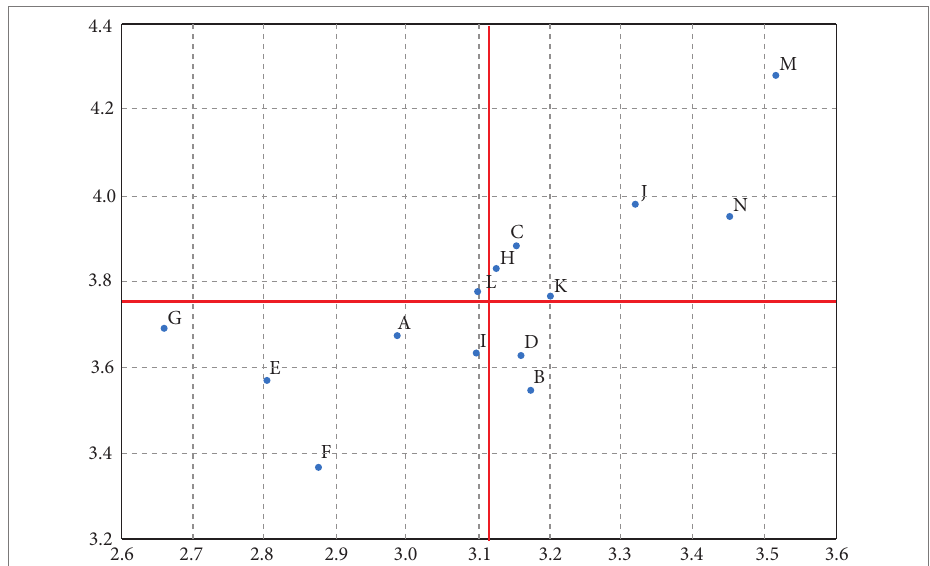
Fig. 6. The scatter diagram of parameters of relations of Polish enterprises with the equipment